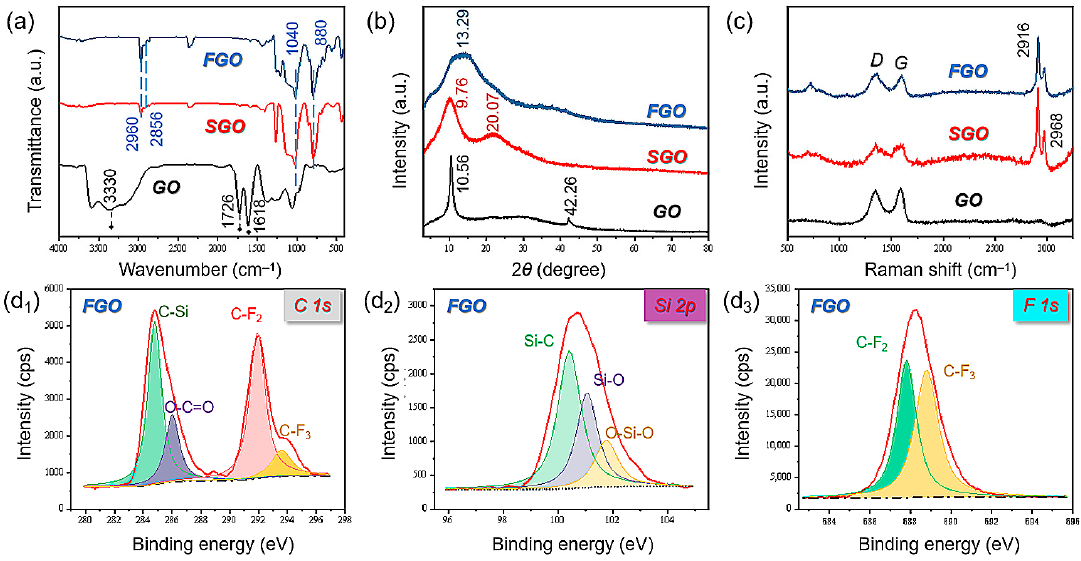
Figure 2. ( a ) FT-IR, ( b ) XRD, ( c ) Raman, and ( d1 – d3 ) XPS spectra patterns of GO, SGO, and FGO.